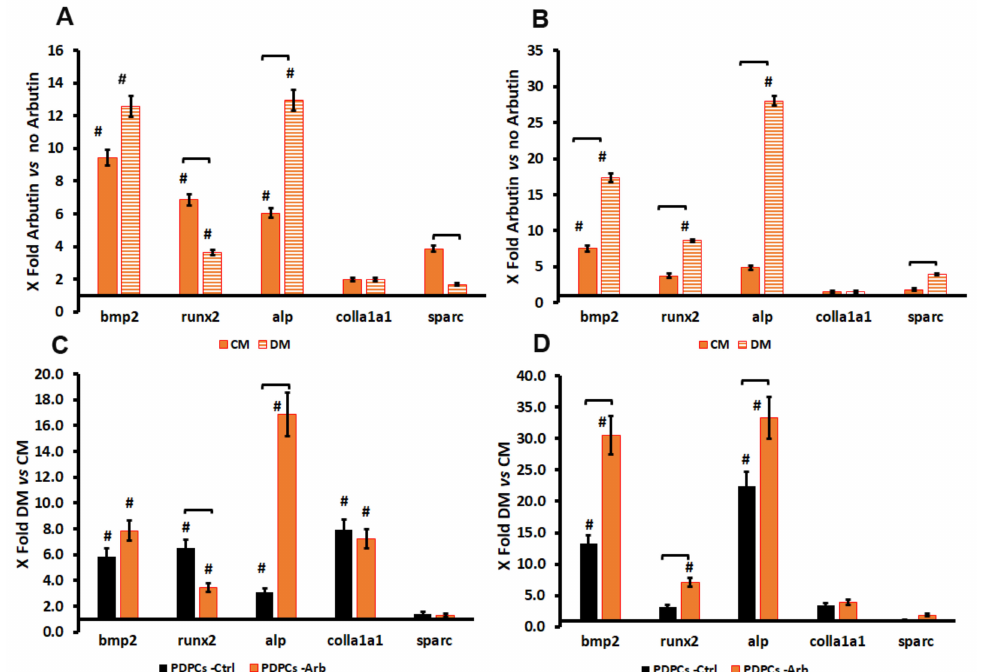
Figure 2. Histograms depicting changes in bmp2, runx-2, alp, collagen type I and sparc mRNA in PDPCs cultured with or without arbutin in complete (CM) or di ff erentiating (DM) medium for 7 ( A , C ) and 14 days ( B , D ). ( A , B ) Data are expressed as fold change (2 − ∆∆ Ct ) as compared to untreated cells (i.e., arbutin vs. no arbutin), The axes intersect at 1, which indicates the mRNA expression in untreated cells. ( C , D ) Data are expressed as fold change (2 − ∆∆ Ct ) as compared to cells cultured in CM (i.e., DM vs. CM), the axes intersect at 1, which indicates the mRNA expression in cells cultured in CM. # indicates significant ( p < 0.05) di ff erences in comparison to controls and square brackets indicate significant di ff erences between the analyzed